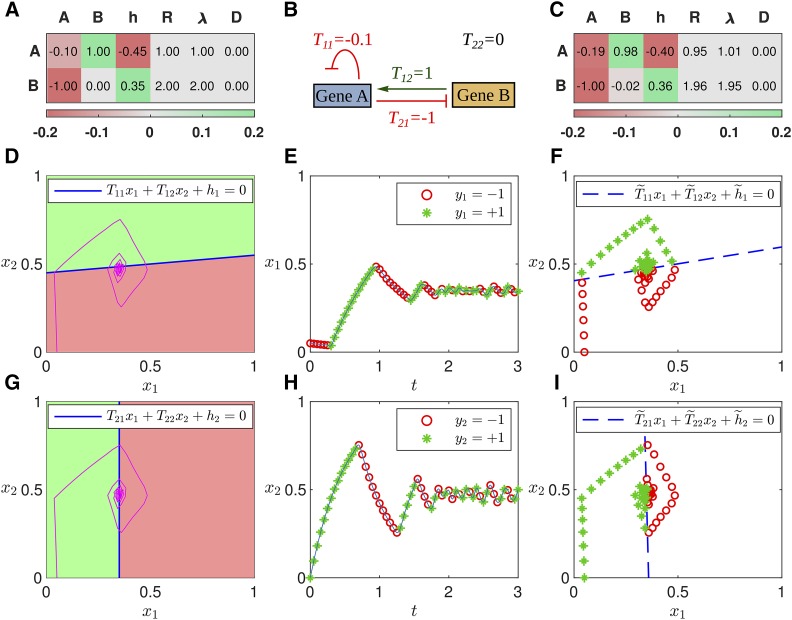
Classification-based inference of an example gene circuit. A. Theoretical parameter values are listed by row for each gene. The T matrix is shown in the first two columns, one column per regulator. Green (red) indicates activation (repression). B. Schematic of the theoretical gene circuit. C. Parameters inferred by FIGR. D,G. Trajectory in state space (purple) overlaid upon the Heaviside regulation-expression function. Green (red) is ON (OFF). The switching hyperplane is plotted as a blue line. Switching hyperplanes for genes A and B are showing in panels D and G respectively. E,H. Sampled gene expression trajectories and assignment of ON/OFF state for genes A (panel E) and B (panel H). Trajectories are numerical solutions of Equation 3. Detected ON or OFF state (Section Determining ON/OFF state) is indicated with green stars or red circles respectively. F,I. Switching hyperplane (dashed blue line) inferred using Logistic regression for genes A (panel F) and B (panel I). Sampled trajectories annotated with ON/OFF state are plotted in state space.